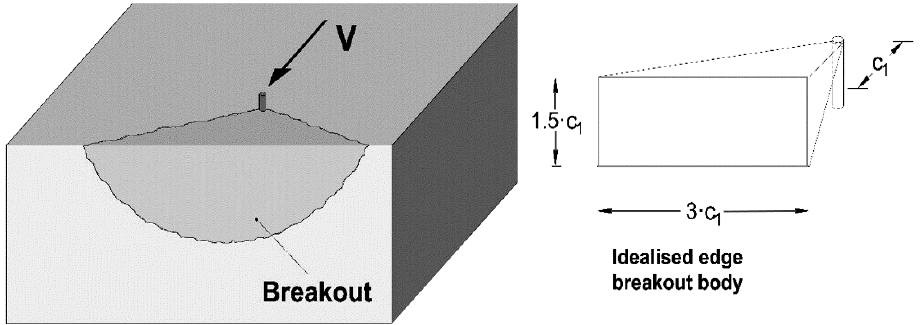
Table 1. Statistical summary of the experimental database.